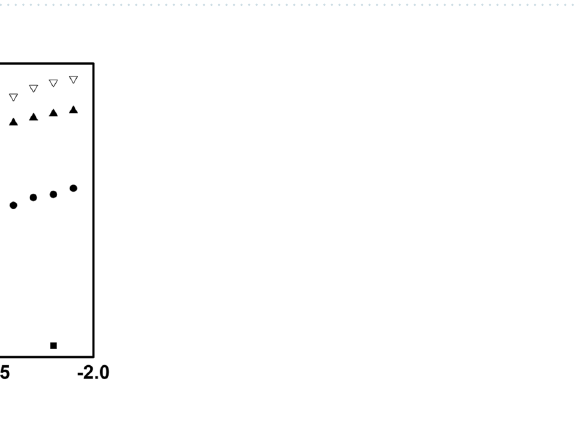
Figure 8. ( a ) Voltage transfer curve of the inverter with interfacial oxidation VTFTs, ( b ) AC characteristics of the inverter.